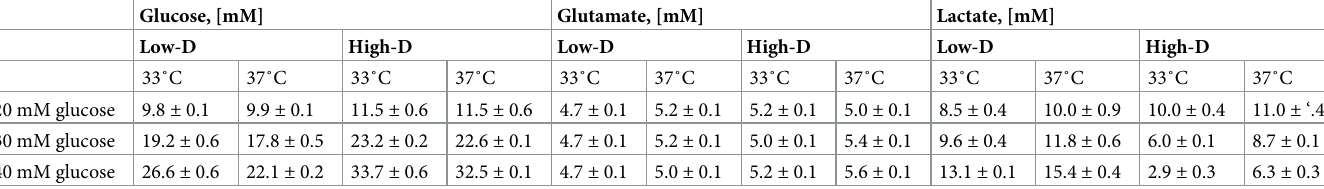
Table 3. Residual concentration of glucose, glutamate and lactate in chemostat cultures at steady state. Glucose, [mM] Glutamate, [mM] Lactate, [mM] Low-D High-D Low-D High-D Low-D High-D 33˚C 37˚C